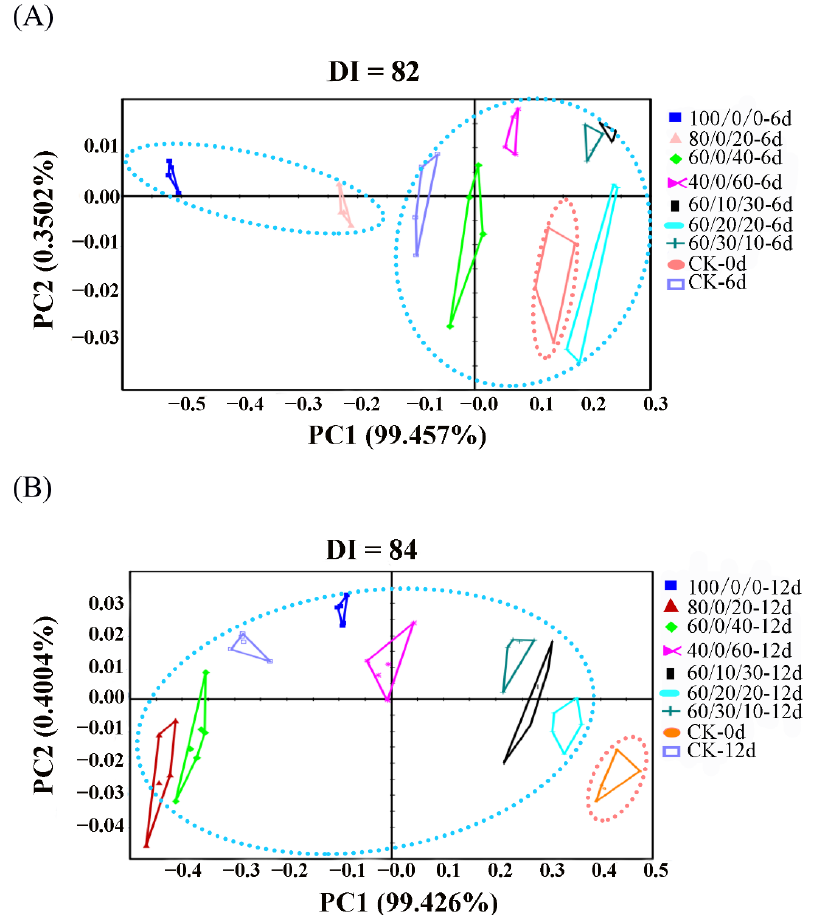
Figure 5. PCA plots of the volatile odor characteristics by electronic analysis of salmon under MAP containing different CO 2 /O 2 /N 2 ratios at 4 °C on day 6 ( A ) and day 12 ( B ) in comparison with CK- 0d.